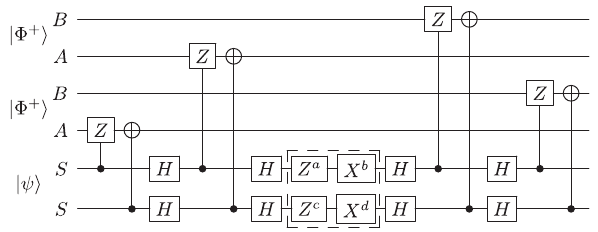
FIG. 6. The full entanglement-assisted PQC for a 2-qubit state with Pauli matrices chosen as unitary operator basis and dephas- ing in the computational and Pauli X